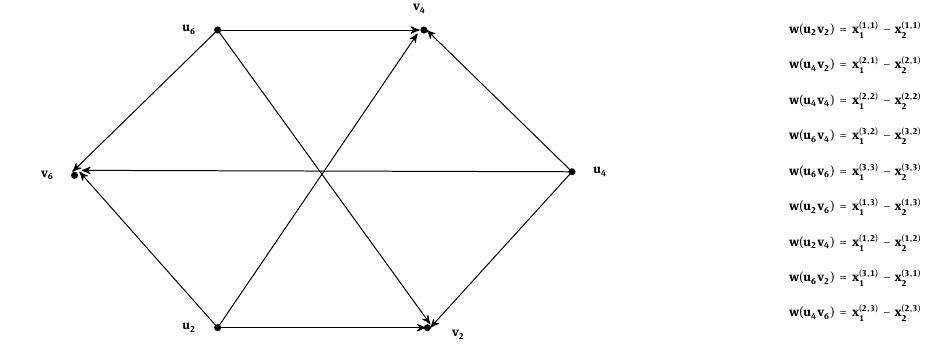
Figure 6: A weighted acyclic digraph Γ 2 . The weight of the corresponding edges appear on figure.